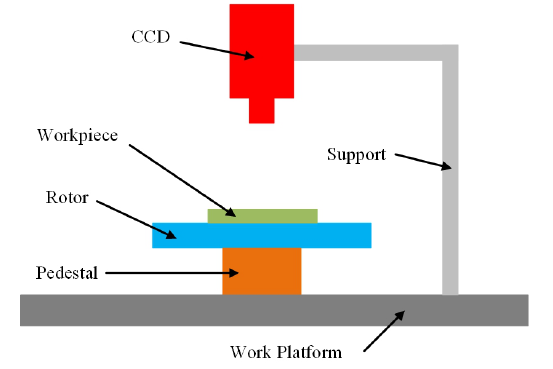
Figure 5. Schematic of the rotation-angle measurement assessment